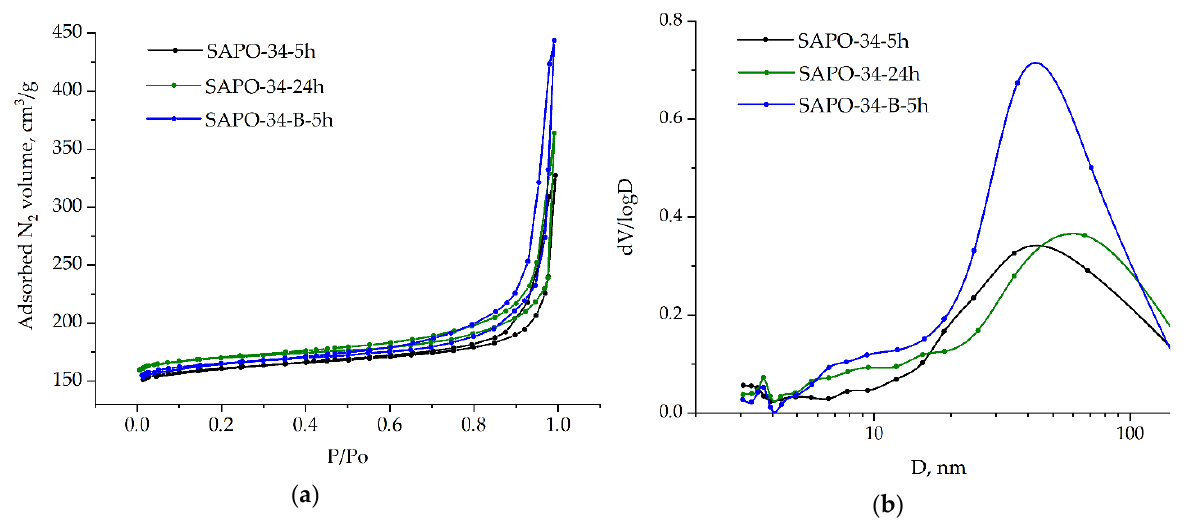
Figure 7. ( a ) Nitrogen sorption isotherms; ( b ) BJH pore size distribution of obtained SAPO-34.